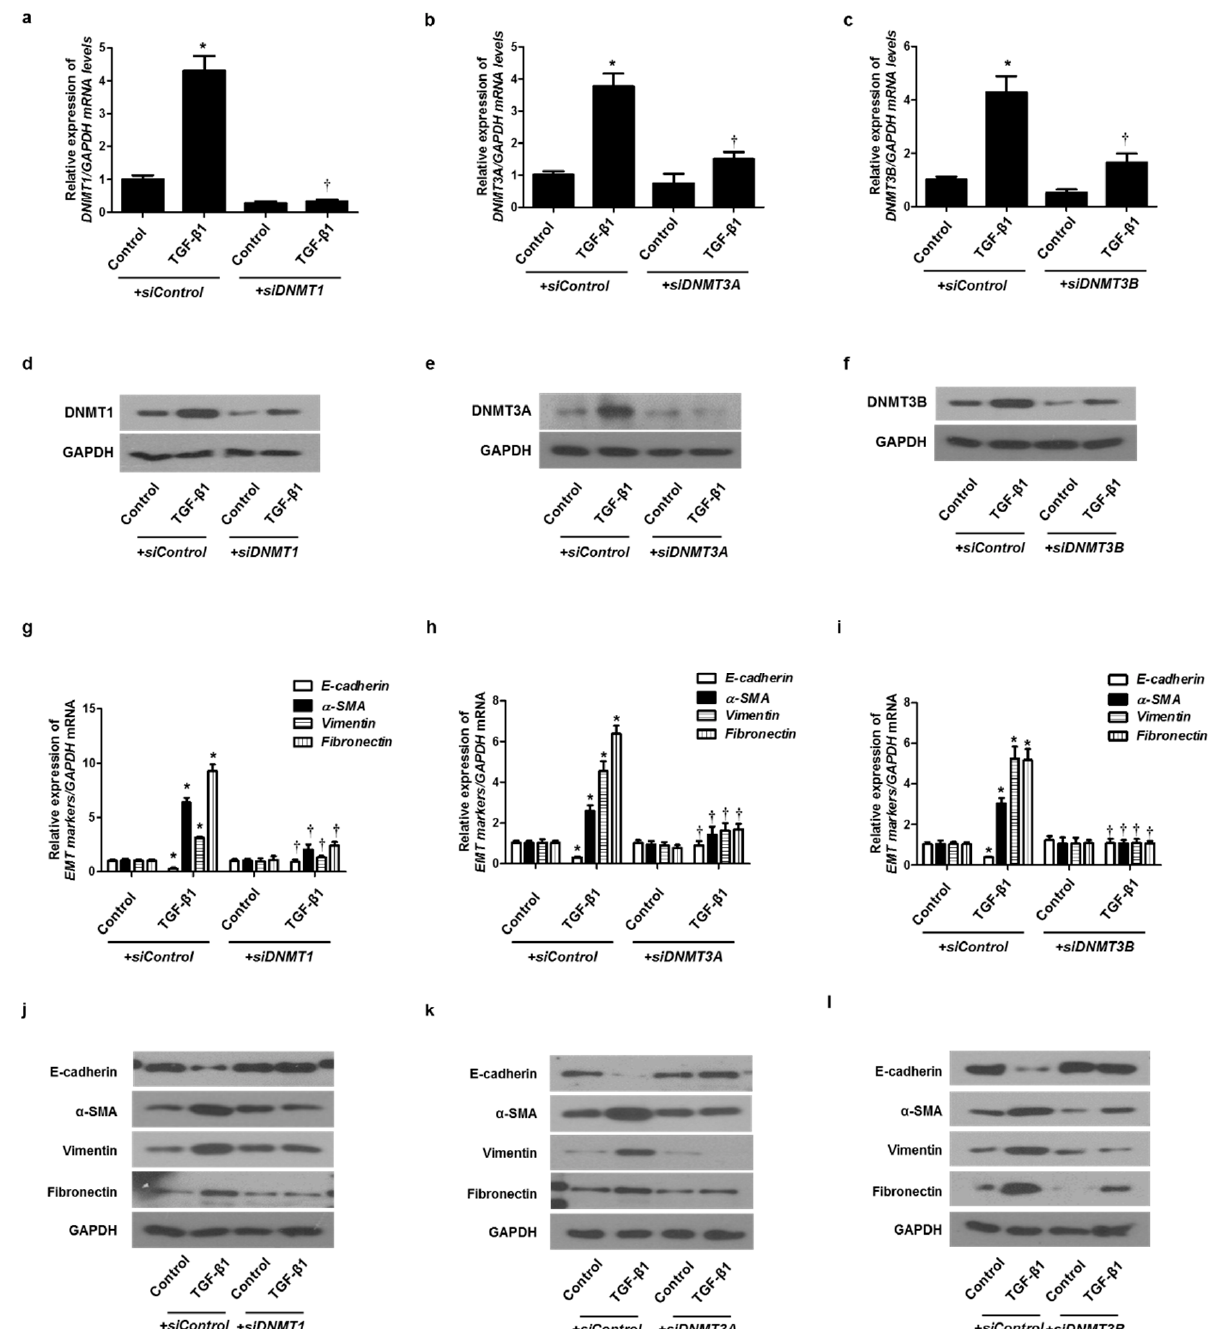
Figure 4. TGF- β 1-induced EMT in A549 cells was inhibited by DNMT1 , DNMT3A , and DNMT3B siRNAs. Specific DNMT1 , DNMT3A , and DNMT3B siRNAs were transfected before treatment with or without TGF- β 1 for 24 h for mRNA expression and 72 h for protein expression in A549 cells: ( a – c ) mRNA levels of DNMT1, DNMT3A, and DNMT3B were determined using real-time PCR; ( d – f ) protein levels of DNMT1, DNMT3A, and DNMT3B were determined using Western blotting; ( g – i )